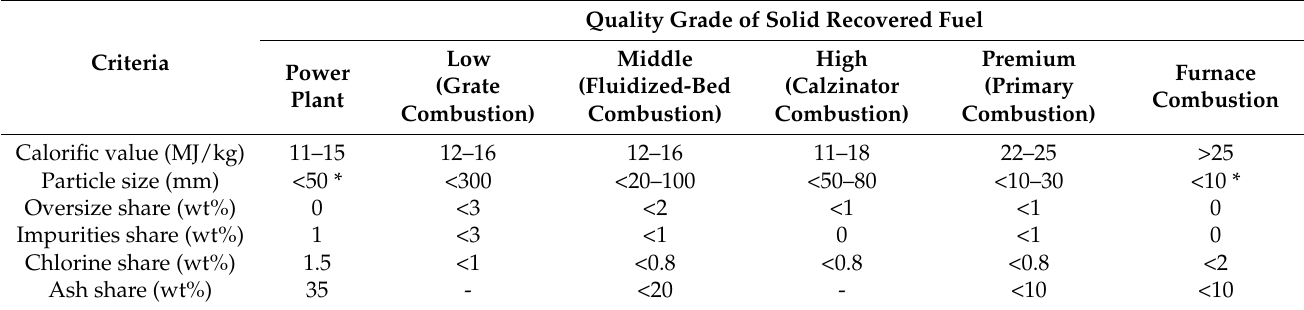
Table 4. Criteria for different quality grades of solid recovered fuel according to the Austrian waste management act [8].